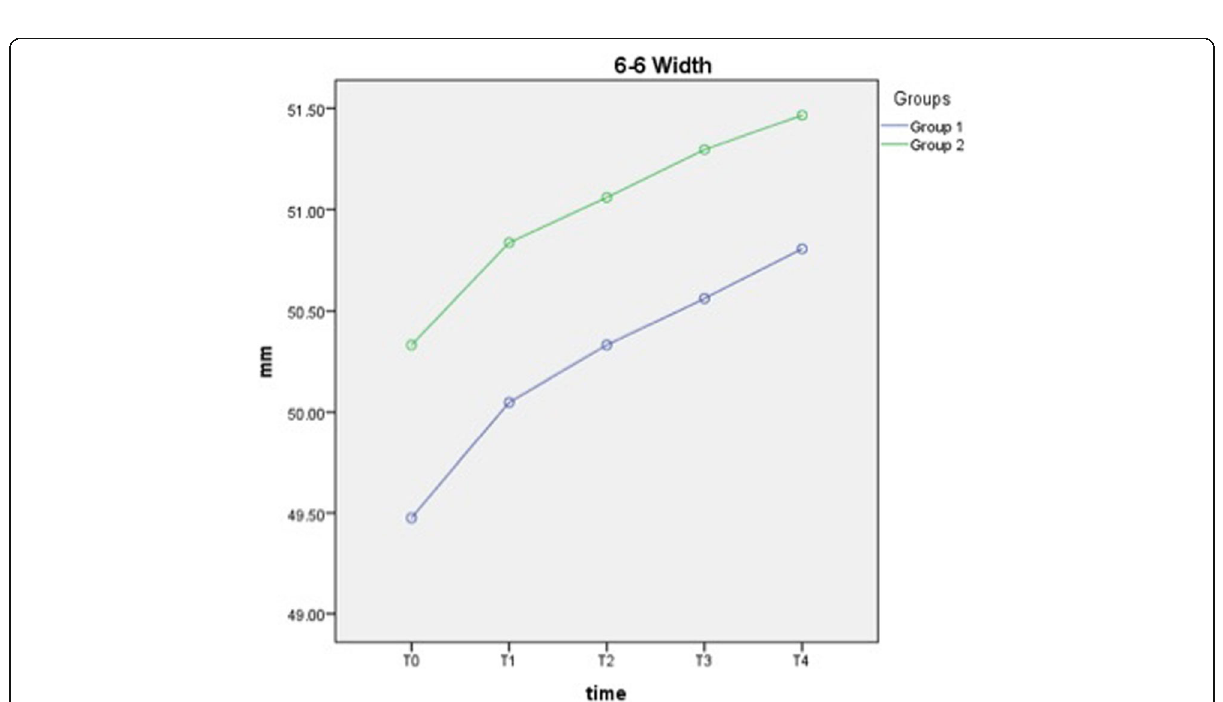
Fig. 5 Change of intermolar width measurements over